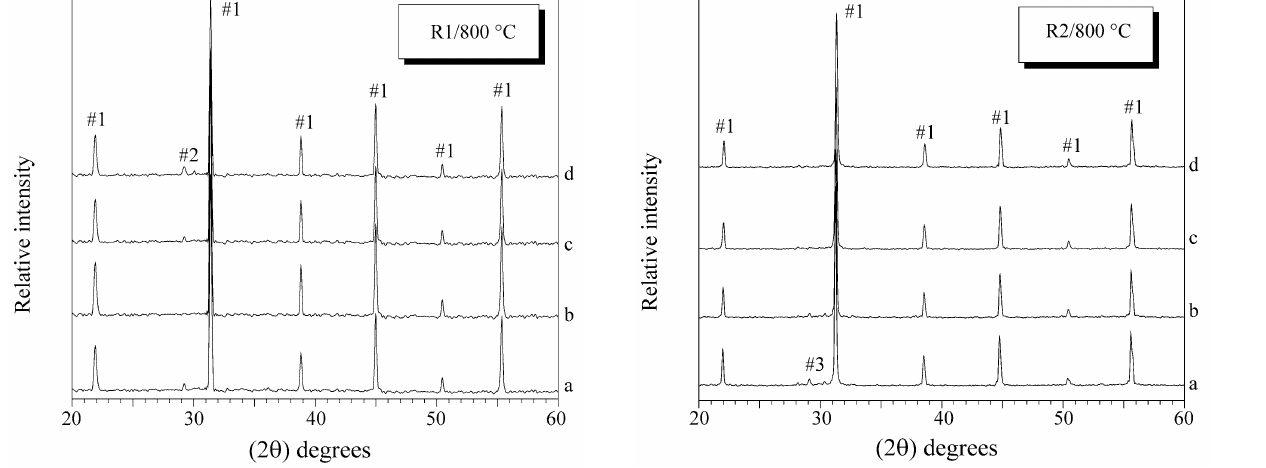
Figure 4. X-ray pattern for PMN powders prepared by route 1, calcined at 800 °C for: a) 1 h, b) 2 h, c) 3 h, d) 4 h.